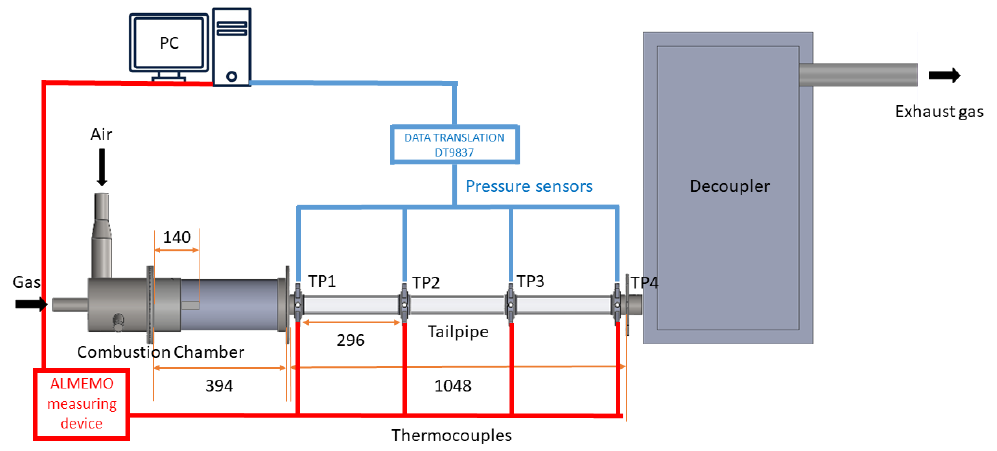
Figure 3. The experimental pulsation reactor setup. The actual orientation is vertical. All dimensions are in